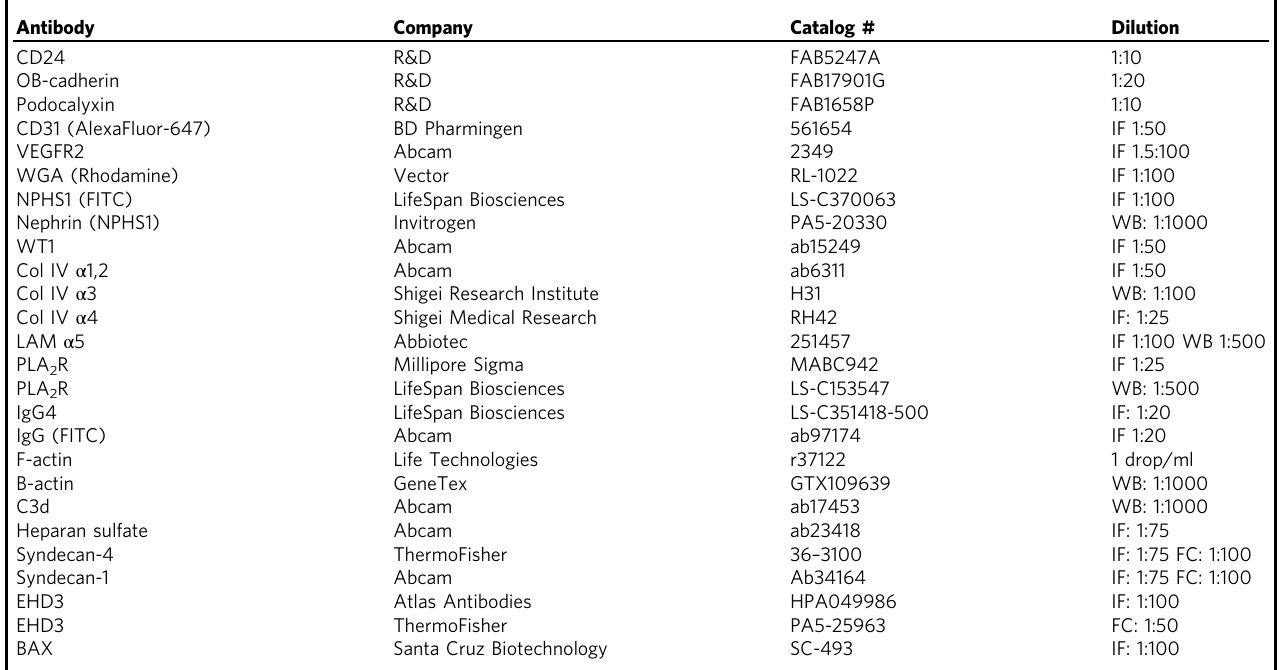
Table 1 List of antibodies and assay-speci fi c